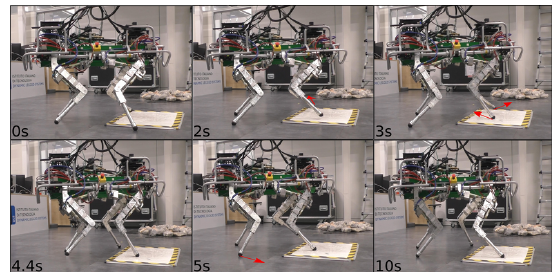
Figure 12. Experiment of the HyQ robot traversing slippery terrain patches with a crawl gait (low friction patches obtained by sprinkling a whiteboard with soap). The image sequence starts from the top left to right and continues at the bottom left. The red arrows indicate slipping